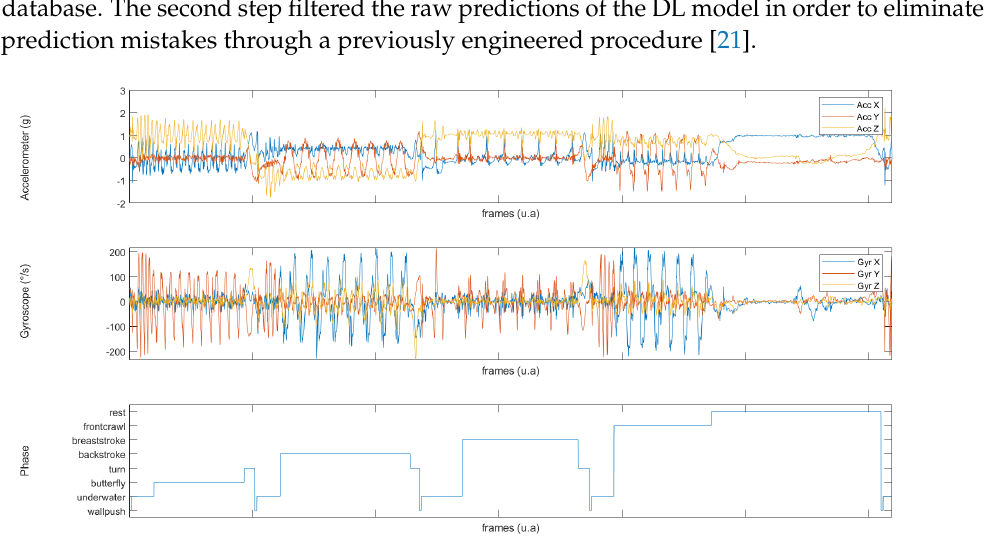
Figure 2. Correspondance between the signal and the true activity of the swimmer: ( top , center ) accelerometer and gyroscope signals for all axes, and ( bottom ) true activity of the signal, presented as activity